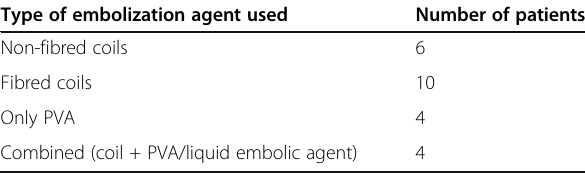
Table 3 Embolizing agent used in managing these patients Type of embolization agent used